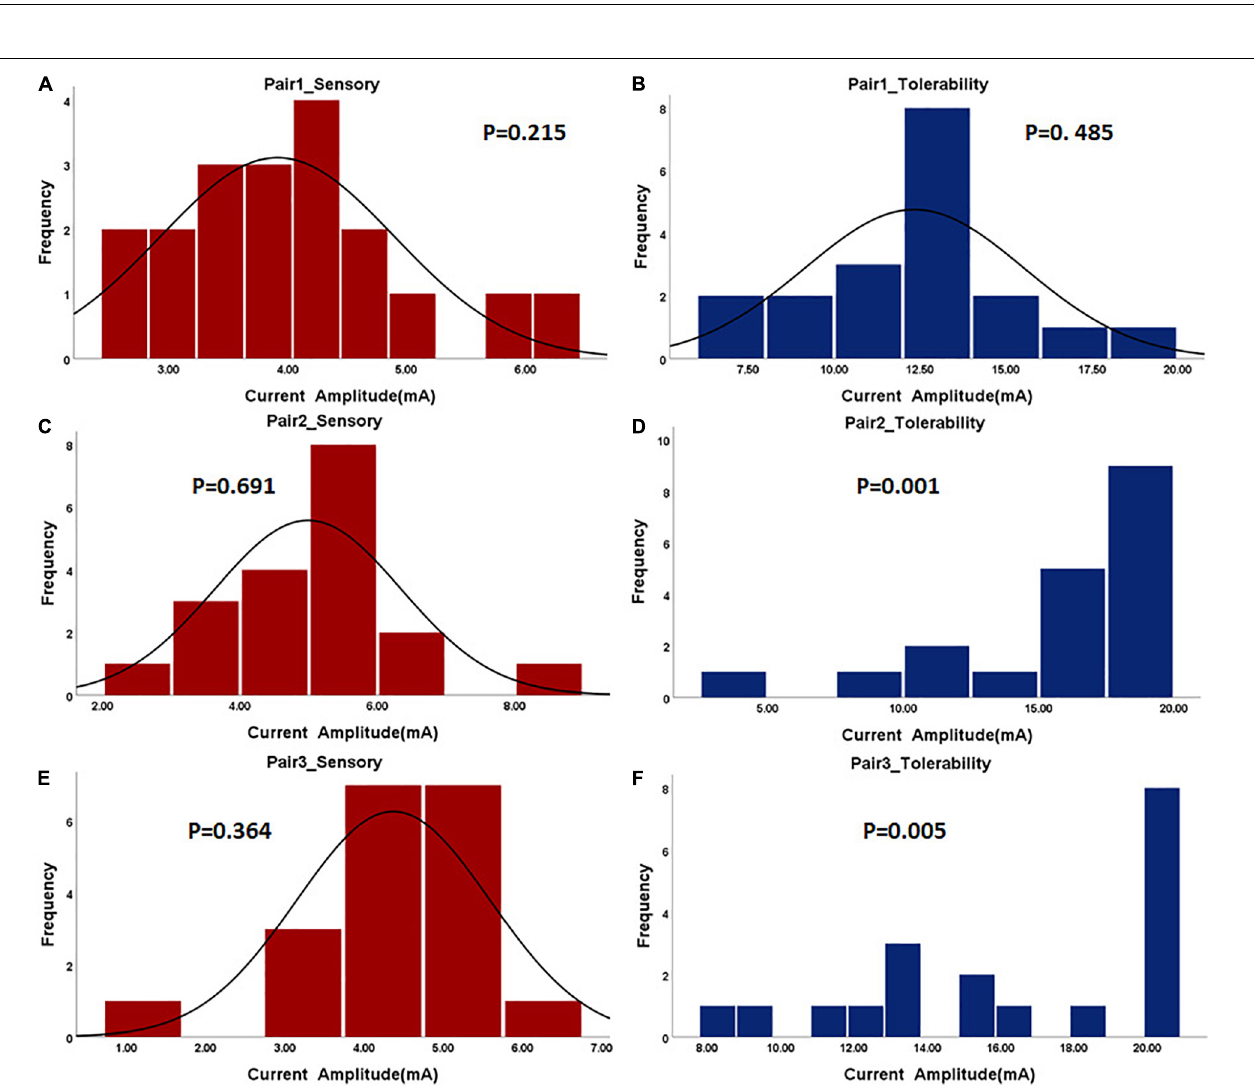
FIGURE 3 | The histogram of sensory and tolerability thresholds of the surface electrode pairs. The P -value of the normality test is shown in each figure. P greater than 0.05 was considered as the normal distribution. (A) Sensory threshold of Pair 1. (B) Tolerability threshold of Pair 1. (C) Sensory threshold of Pair 2. (D) Tolerability threshold of Pair 2. (E) Sensory threshold of Pair 3. (F) Tolerability threshold of Pair 3.